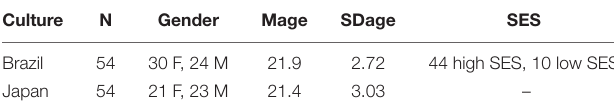
TABLE 1 | Participants demographic